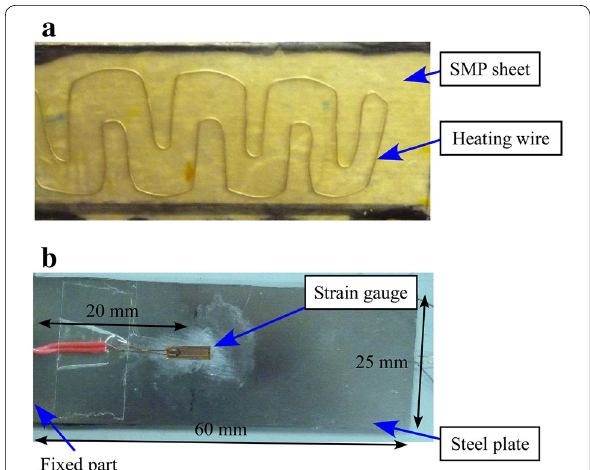
Fig. 10 Second prototype of force sensor using SMP sheet bonded to steel plate. a Top view. b Bottom view. In order to measure the strain on the surface of the steel plate, one strain gauge was bonded on the steel